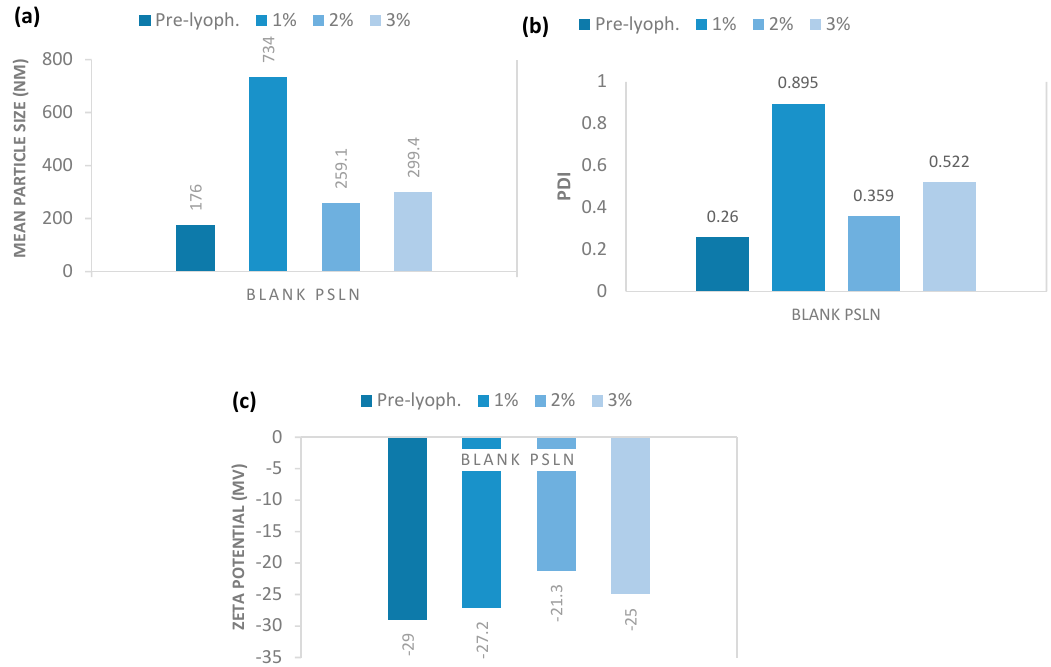
Figure 6. ( a ) Mean particle size (Z-Ave), ( b ) polydispersity index (PDI), and ( c ) zeta potential of blank pSLNs using increasing concentrations of glucose.